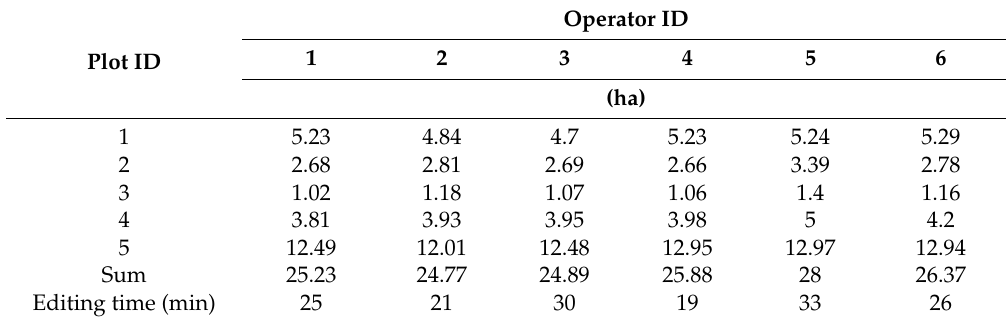
Table 3. Comparison of edited windthrow areas and editing time of operators using the UAS method.